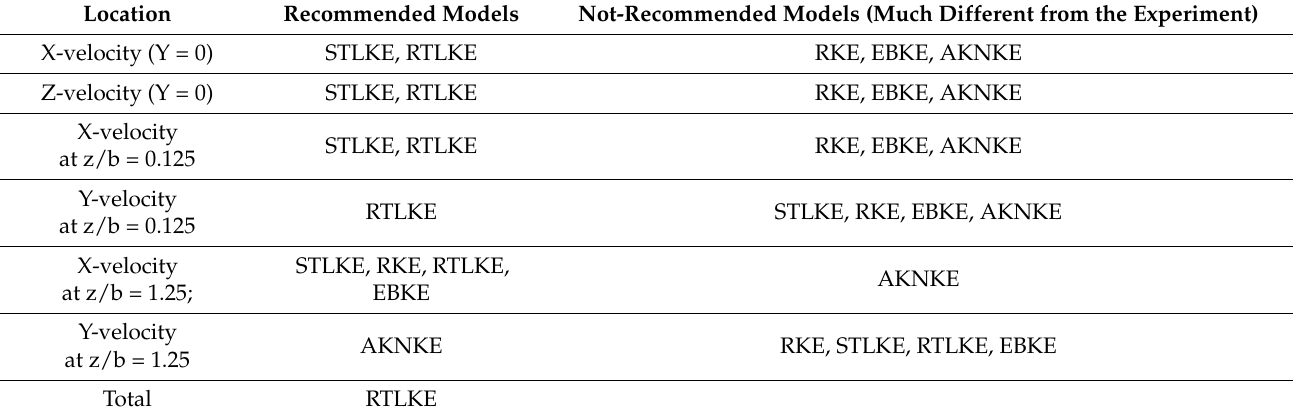
Table 10. Comparison of wind speeds in the low wind-speed area.